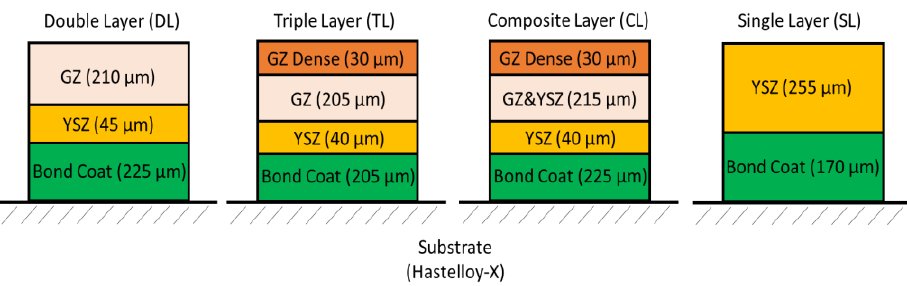
Figure 1. Schematic representation of the investigated multilayer and single layer TBC.